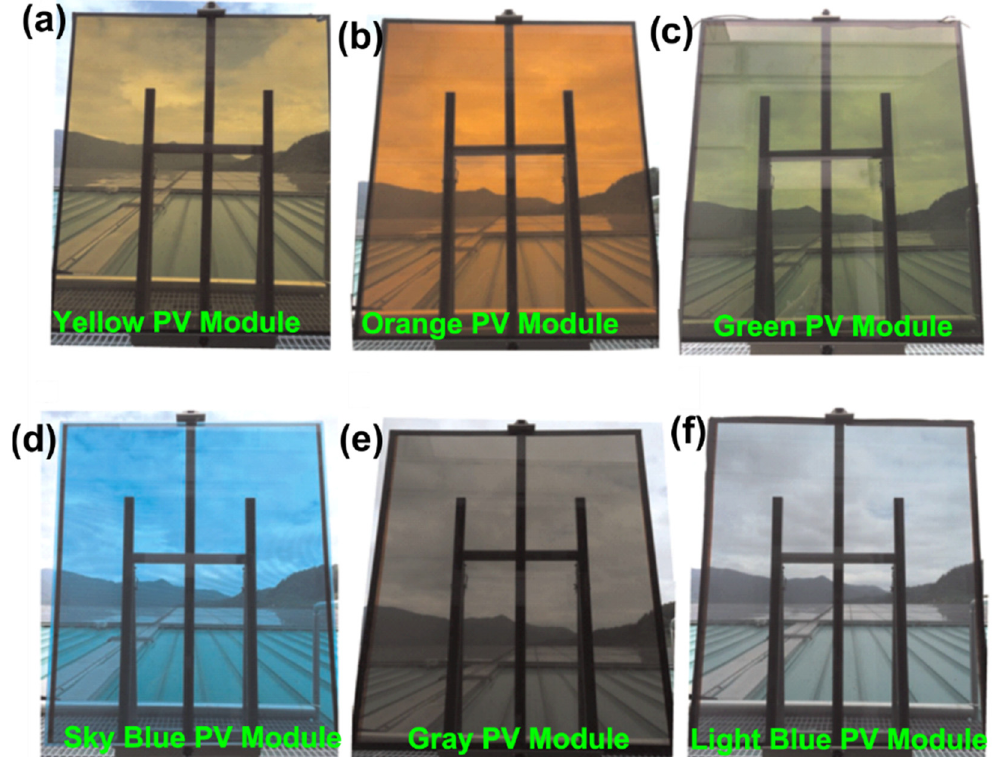
Figure 6. Front views of the fabricated a-Si:H semi-transparent glass-to-glass (GTG) PV module. ( a ) yellow PV module, ( b ) orange PV module, ( c ) green PV module, ( d ) sky blue PV module, ( e ) gray PV module, and ( f ) light blue PV module (reproduced and modi fi ed with permission from Ref. [77]).